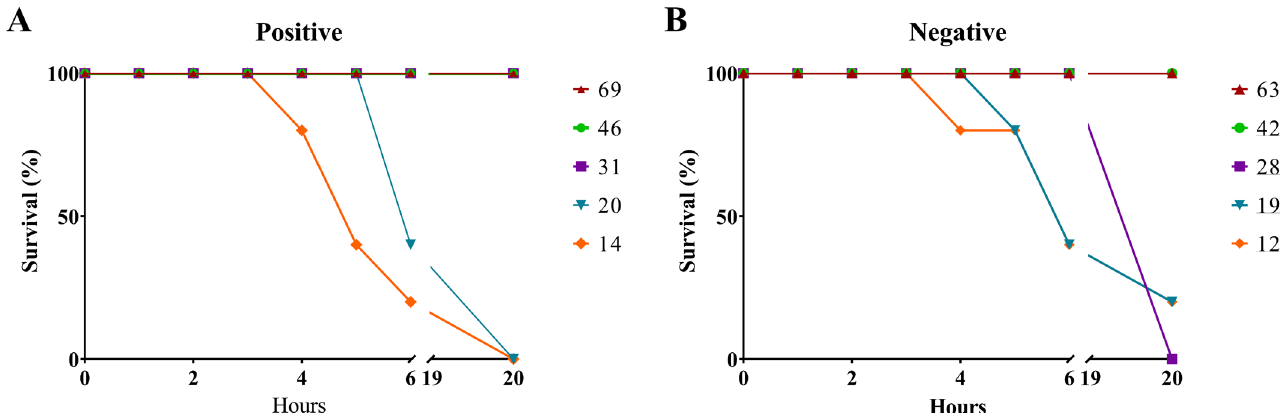
Figure 9. Effective dose of venom pools from C. durissus . Survival of mice of different groups according to time to death after injection of (A) crotamine- positive and (B) crotamine-negative venom pools pre-incubated with crotalic antivenom. Different colors represent different doses (µL